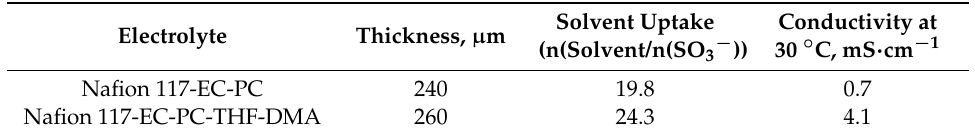
Table 1. Physical properties of membrane electrolytes.